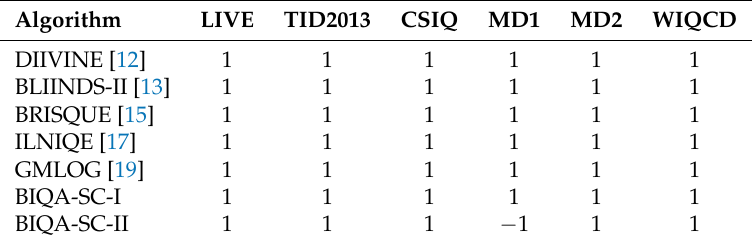
Table 3. Results of the t -test between the SROCC results generated by the competing algorithms across the 1000 train-test trials on benchmark databases. The symbols 1, − 1, and 0 indicate that BIQA-SC is statistically superior, inferior, or indistinguishable to the compared